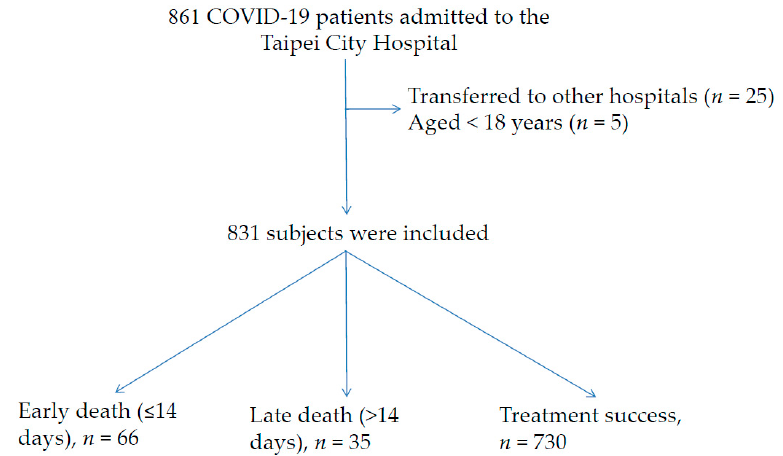
Figure 1. The process of enrollment in patients with COVID-19 infection.